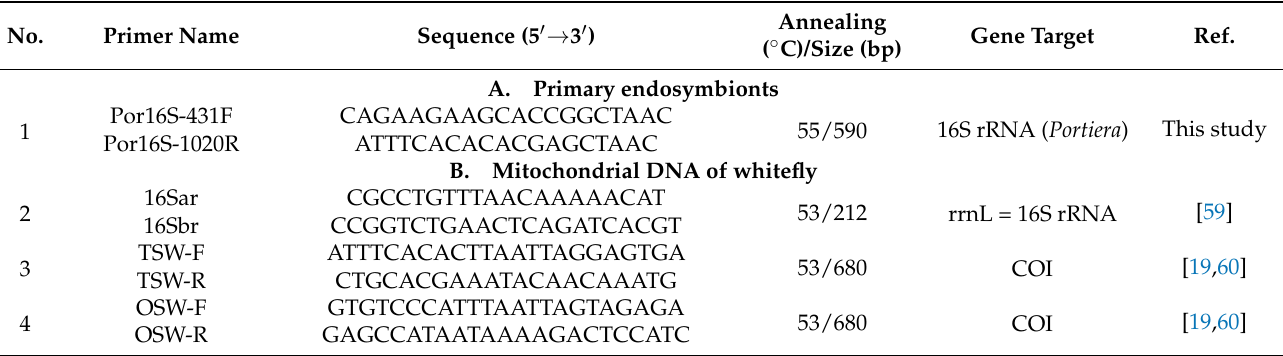
Table 1. Universal and specific primer